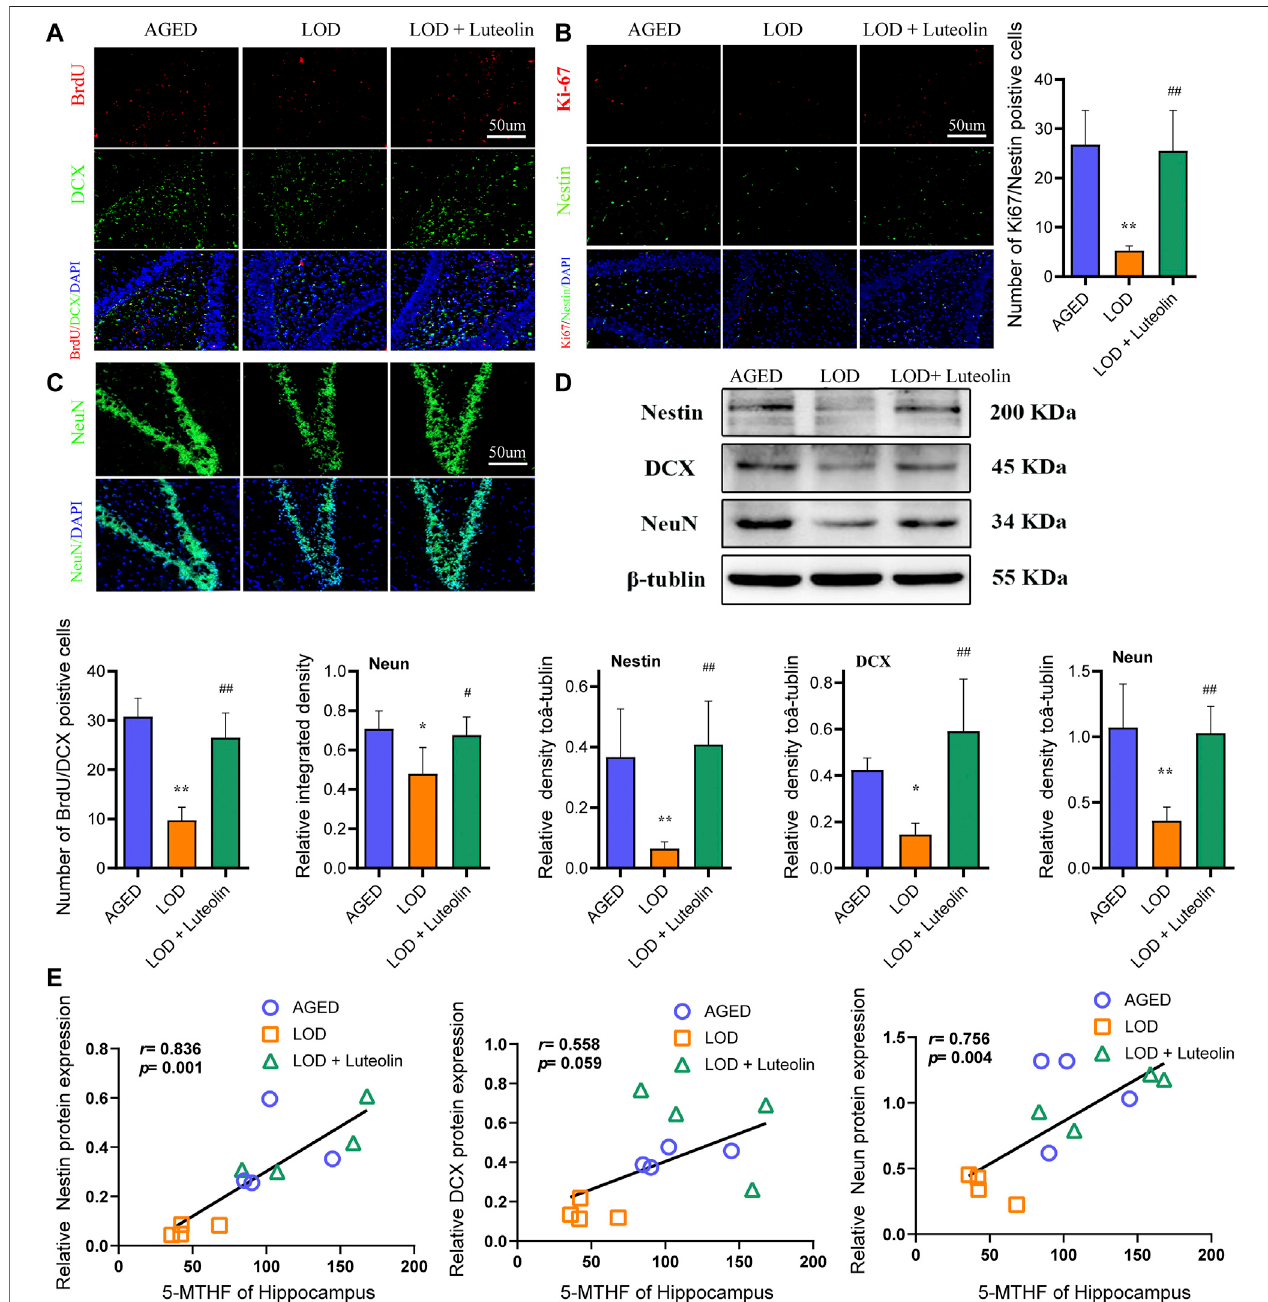
FIGURE4| EffectsofluteolinonthenumbersofBrdU/DCX,Ki-67/Nestin,andNeuN-positivecellsinthehippocampus.QuantitativeanalysisofDCX/BrdUdouble- positive cells, Ki-67/Nestin double-positive cells, and NeuN-positive cells in the hippocampus DG region (A – C) ( n = 4), Magni fi cation ×10. Representative Western blottingimagesofNestin,DCX,andNeuNproteinlevelsinthehippocampus (D) ( n =4).Correlationsbetween5-MTHFandNeuNlevelsinthehippocampus,between5- MTHFandDCXlevelsinthehippocampus,andbetween5-MTHFandNestinproteinlevelsinthehippocampus (E) ( n =4).Dataineachgroupwereconsistentwith anormaldistribution(Shapiro – Wilktest)andexhibitedhomogeneityofvariance;one-wayanalysisofvariancewasthenusedforcomparisons.Dataareexpressedasthe mean ± SEM, * p < 0.05, ** p < 0.01, vs. AGED; # p < 0.05, ## p < 0.01, vs. LOD.